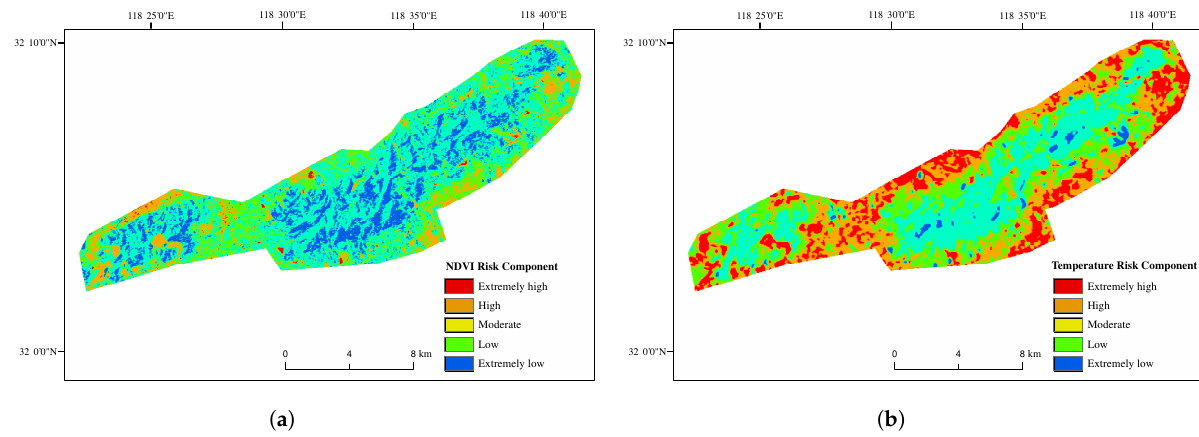
Figure 12. The fire risk map of NDVI and temperature. ( a ) The risk map of NDVI . ( b ) The risk map of temperature. The fire risk level of each factor is determined by the fire risk classification